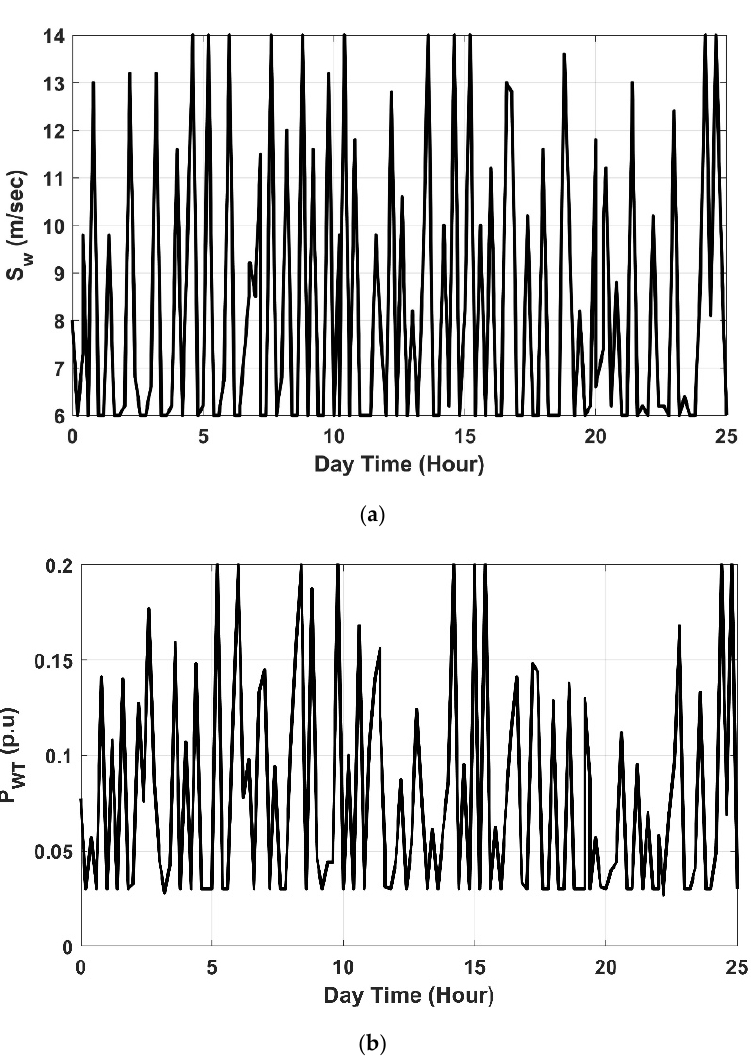
Figure 3. ( a ) The wind speed fluctuation and ( b ) the wind turbine out-power variation.